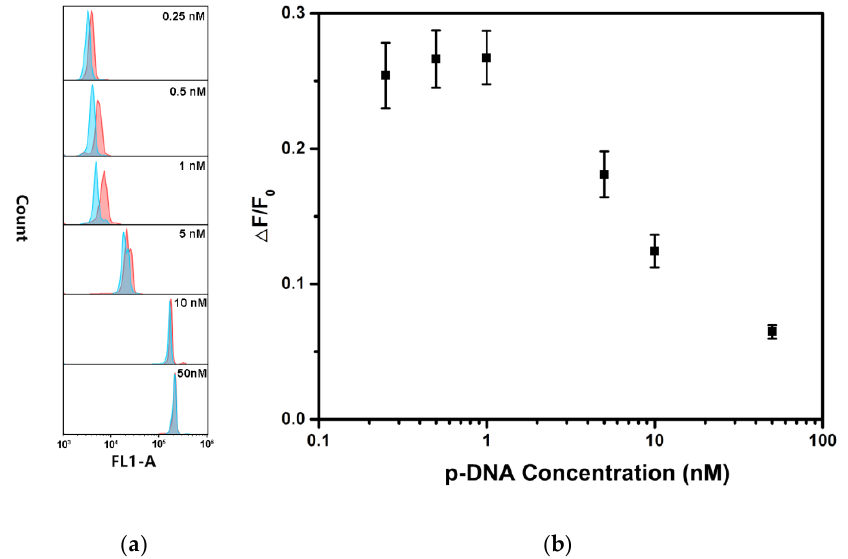
Figure 1. Effect of the p-DNA concentration on the detection of hsa-miR-146-5p: ( a ) fluorescence responses of the as-prepared MB@dsDNA treated with 100 pM hsa-miR-146b-5p (blue lines) in comparison with blank control (red lines) under different p-DNA concentrations from up to down (0.25, 0.5, 1, 5, 50 and 50 nM), respectively; and ( b ) the ΔF/F 0 as a function of p-DNA concentration. Error bars mean standard deviations ( n = 3).